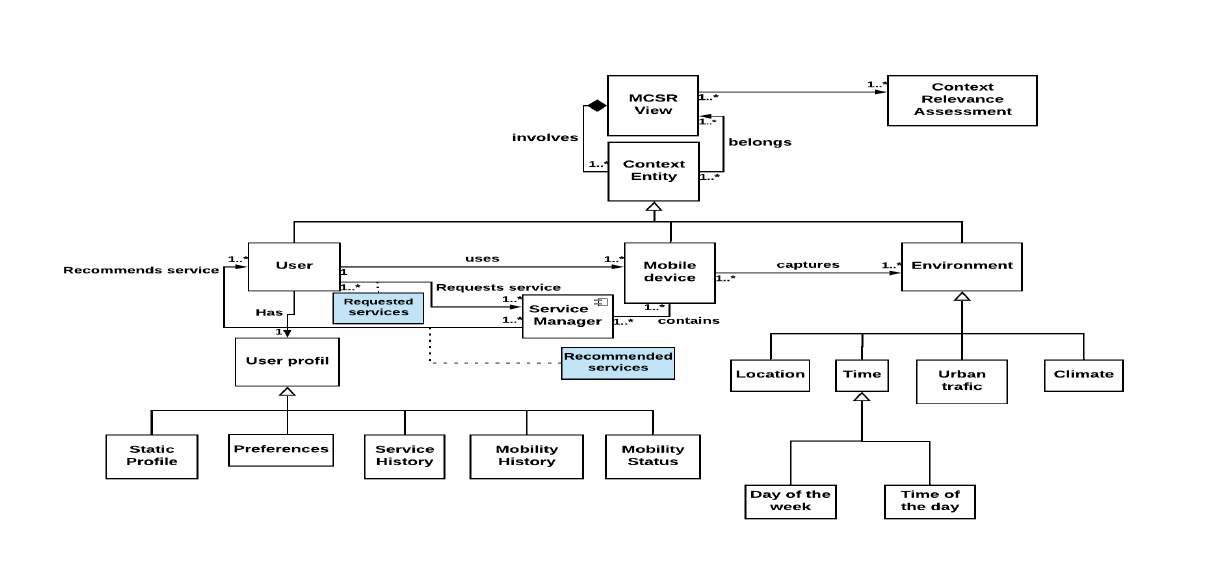
Figure 3. Context model for mobile personalized service recommendation in smart